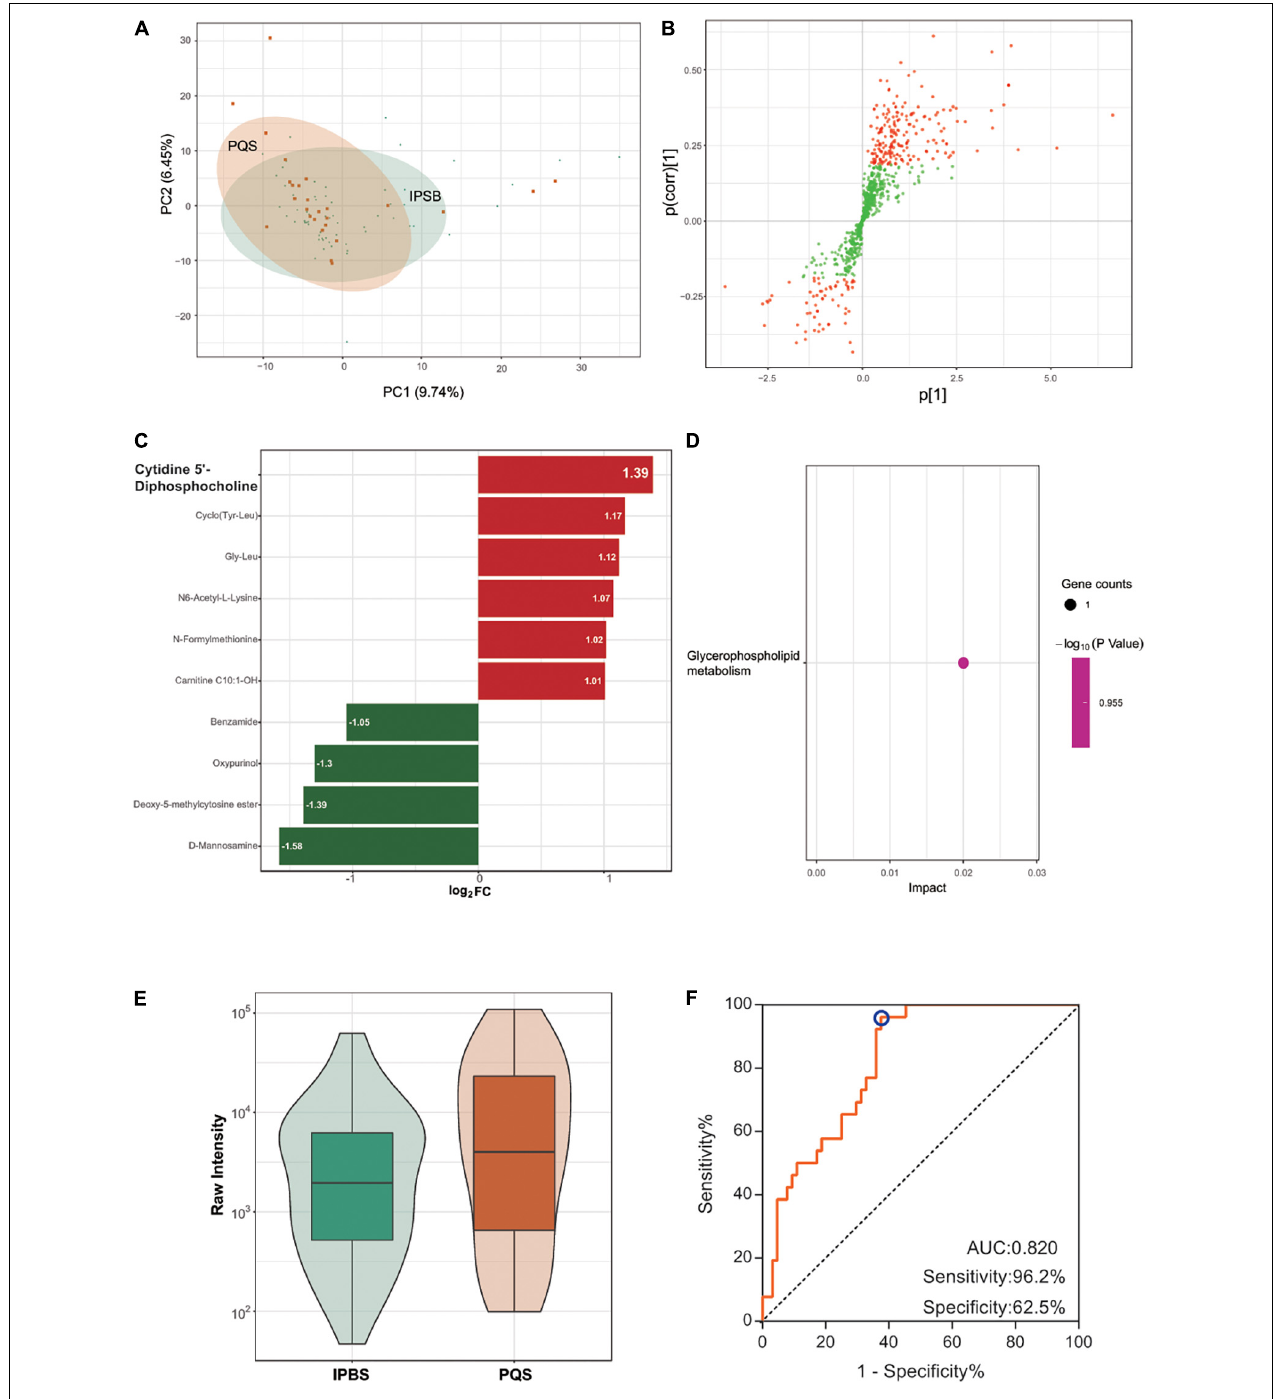
FIGURE 4 | Comparison between IPBS and PQS. (A) The PCA plot between IPBS and PQS. Each point in the graph represents a sample, the different colors of the points represent the grouping of the samples, the differences are not distinct in the plot. (B) OPLS-SPlot between IPBS and PST. VIP > 1, red plots represent different regulated metabolites. (C) The column chart shows different regulated metabolites between IPBS and PST. Red bars represent upregulated metabolites in PQS, green bars represent downregulated metabolites in PQS. Data are shown in log2 scale. (D) KEGG analysis of different regulated metabolites between IPBS and PQS; glycerophospholipid metabolism was the main enriched pathway. (E) The violin diagram shows the most significantly upregulated metabolites. Cytidine 5 (cid:48) -diphosphocholine is the top upregulated metabolite in PQS. (F) ROC curve of the prediction model to identify IPBS and PQS. AUC is 0.82, sensitivity is 0.962, and specificity is 0.625; the blue circle represents the truncation